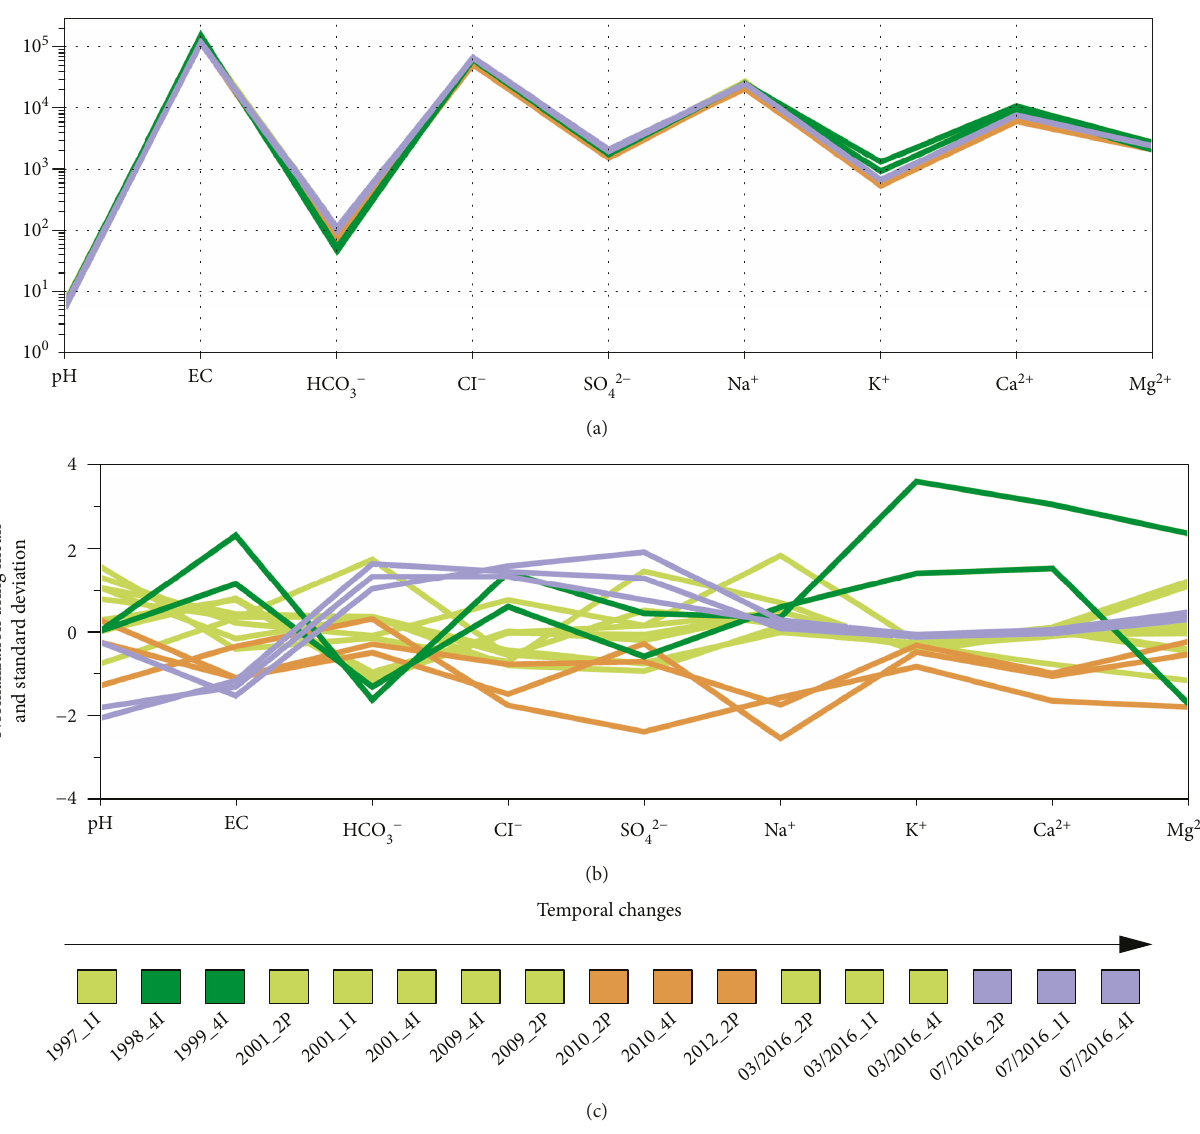
Figure 5: Absolute concentrations (a) and normalised concentrations (using mean and standard deviations) (b) of major constituents in the Klaipeda brines plotted in Schöller diagrams. Temporal changes in water composition and the colour-coded groups of samples (identi fi ed using self-organizing maps) are shown in the lowermost plot